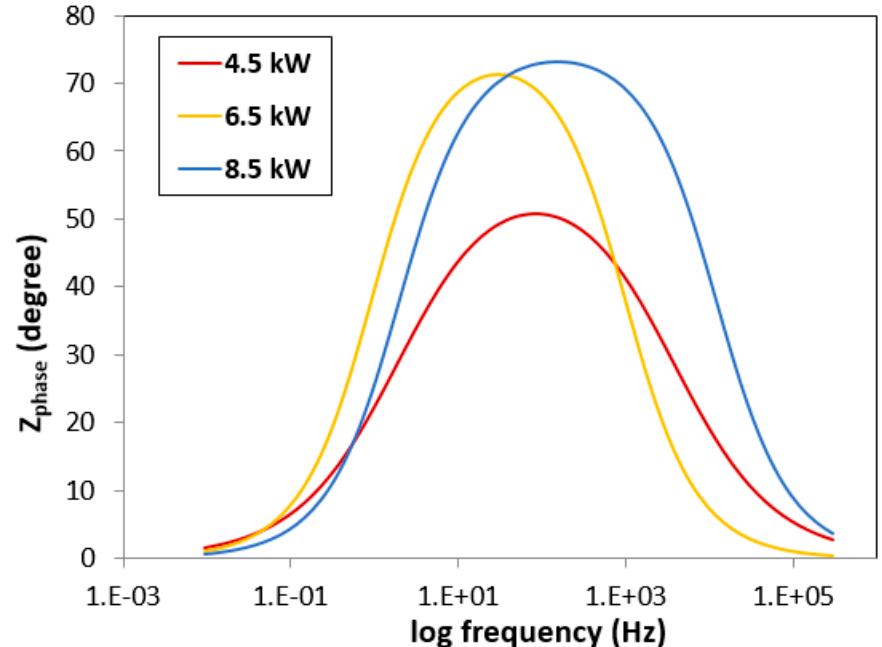
Figure 7. Bode phase plot of 2205 duplex stainless steel in 3.5% NaCl solution.